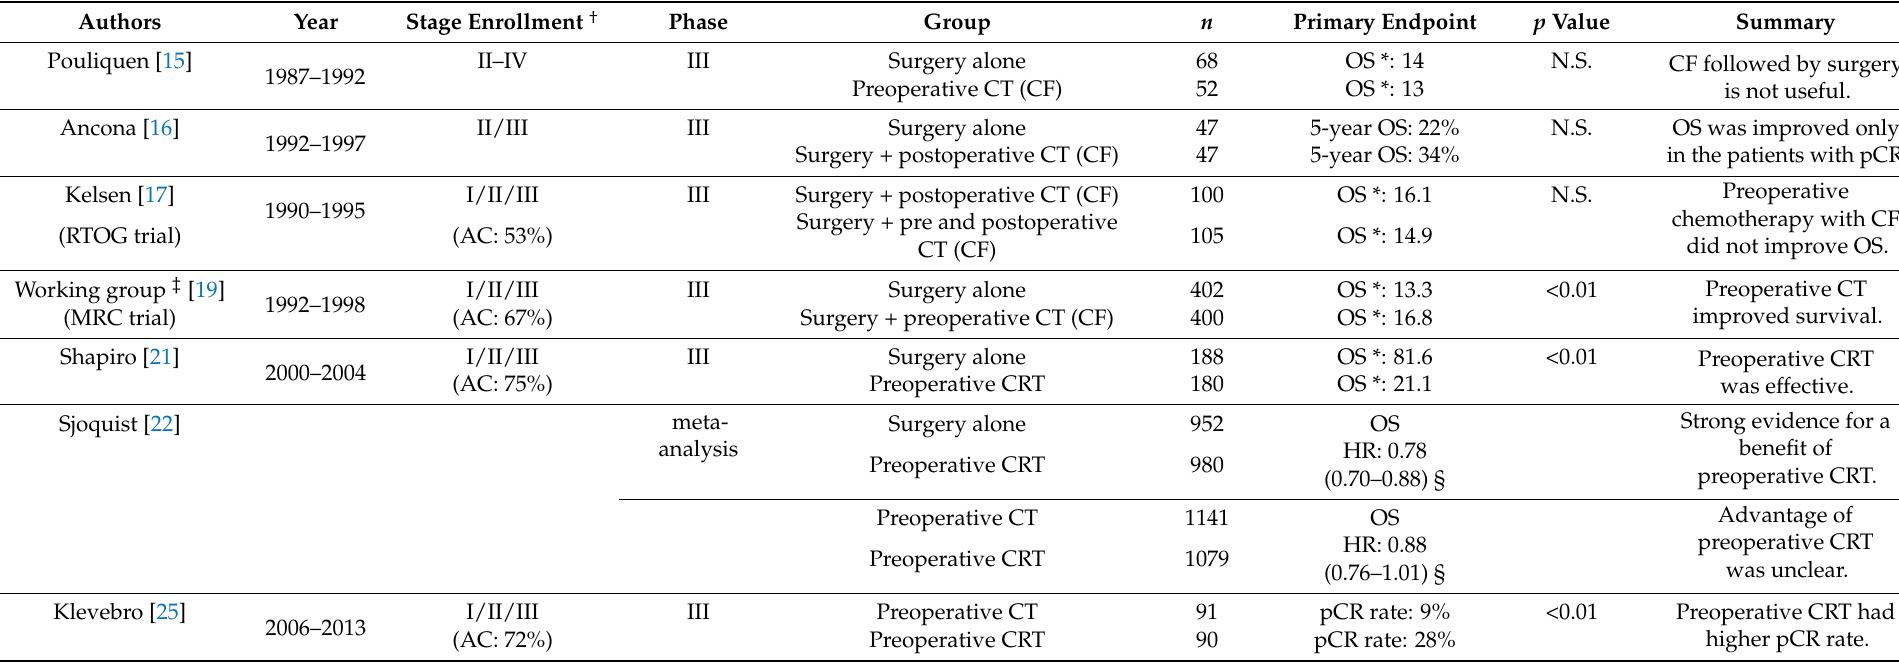
Table 2. Overview of clinical trials of adjuvant therapy for ESCC in Western